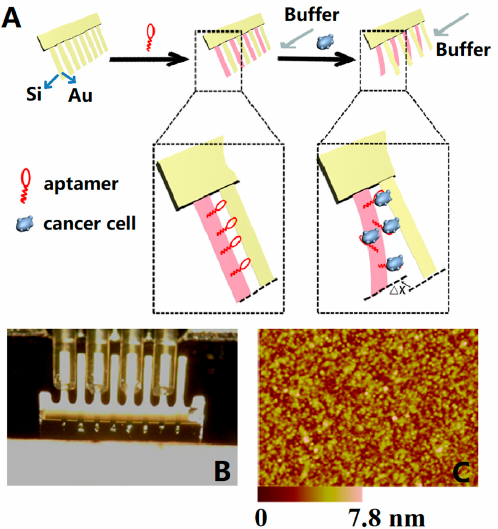
Figure 11. ( A ) A schematic illustration of the mechanism of HepG2 cells determined by a microcantilever array sensor; ( B ) functionalization procedure of microcantilevers by immersing into capillaries containing TLSIIa aptamers; ( C ) AFM topography image of aptamers (1 μ mol/L) on gold surface (2 μ m × 2 μ m) [45].